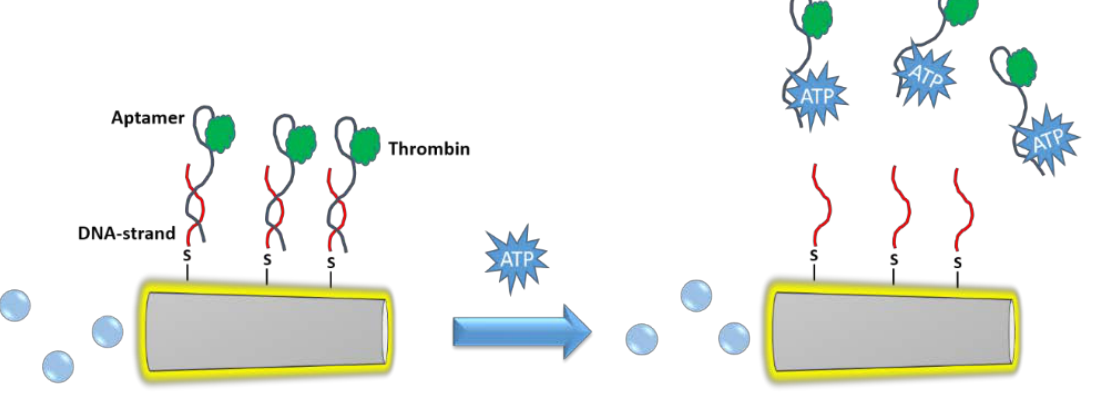
Figure 2. Microrocket for capture and release of thrombin mediated by aptamers and ATP.